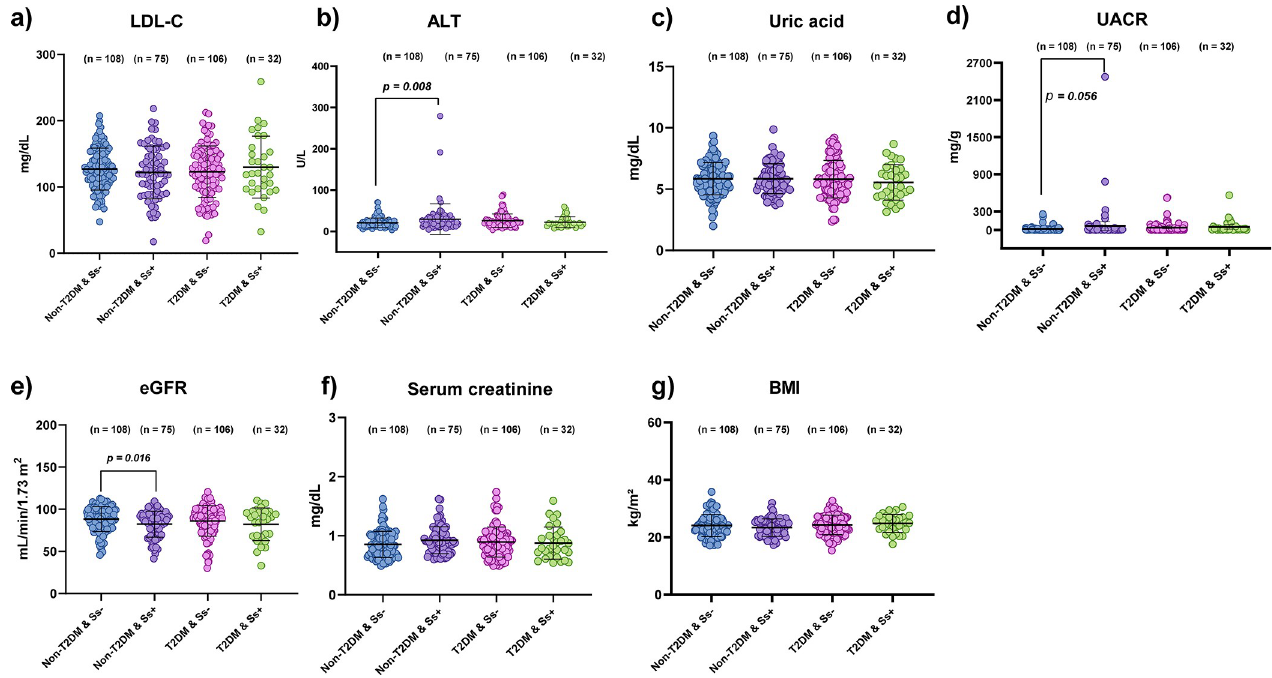
Fig 3. Association of S . stercoralis infection with biochemical profiles BMI and T2DM (matching sex and age between groups). a): Direct low-density lipoprotein cholesterol: LDL-C; b): Alanine transaminase: ALT; c): Uric acid; d): Urine albumin-to-creatinine ratio: UACR; e): Estimated glomerular filtration rate: eGFR; f): Serum creatinine; g): Body mass index: BMI. Lines indicate mean and standard deviation (SD) of data. Statistical significance based on one-way ANOVA.